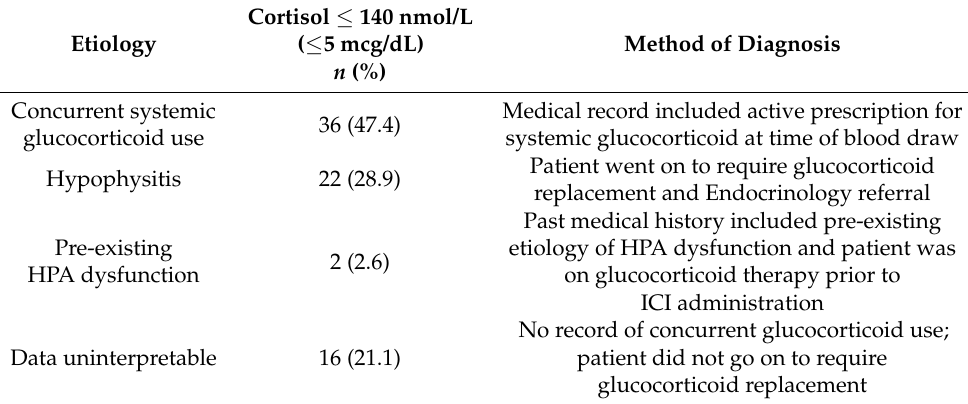
Table 2. Etiology of low serum cortisol